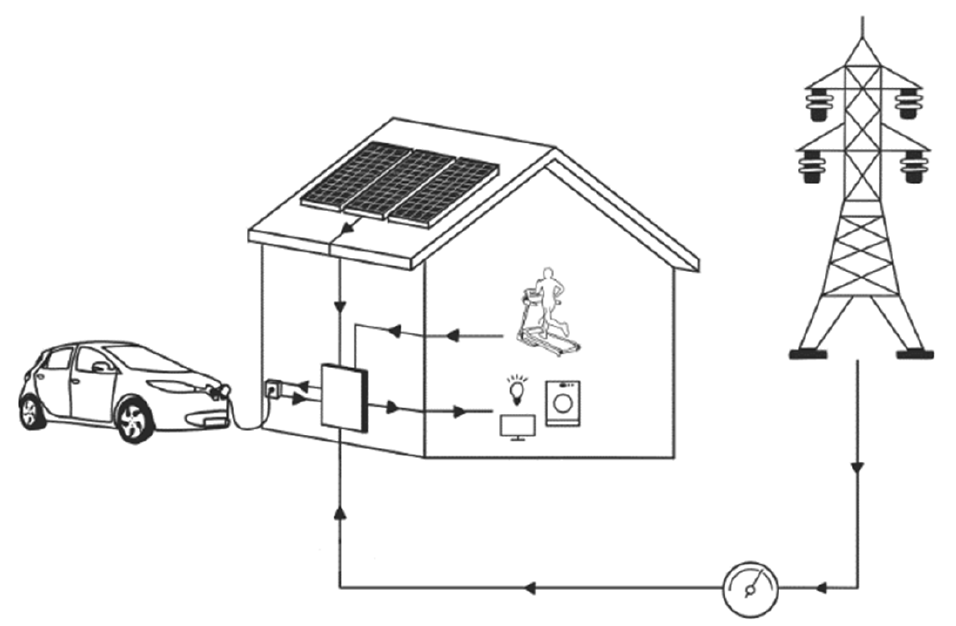
Figure 7. DC home design with PV, HESS, EV and HED.